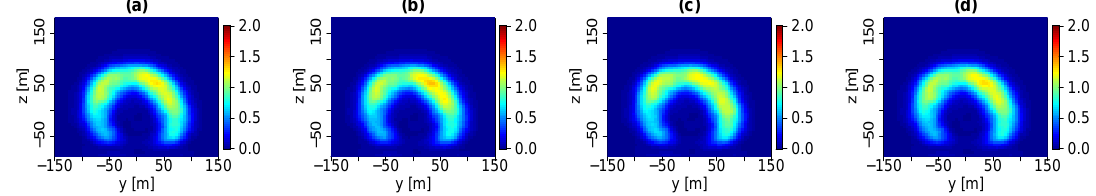
Figure 16. Local SKE (cid:104) u (cid:48) ( y , z ) 2 (cid:105) t ( m 2 s − 2 ) using N = 6 POD modesfor truncated POD and the different stochastic wake models: ( a ) truncated POD; ( b ) spectral model ; ( c ) OU-based model ; ( d ) uncorrelated model .